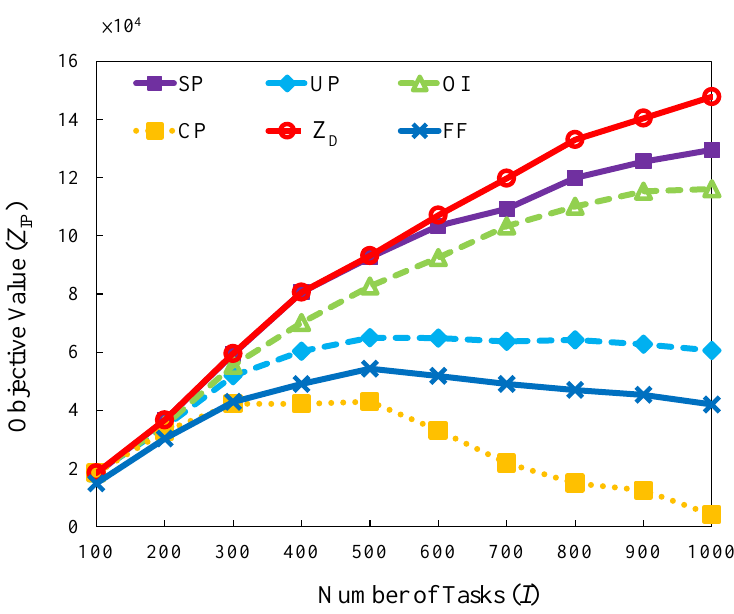
Figure 9. Objective value versus different number of tasks in bursty traffic load.